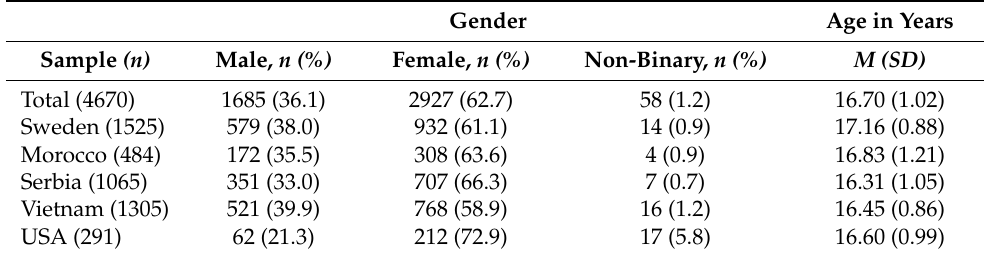
Table 1. General demographic information of the study